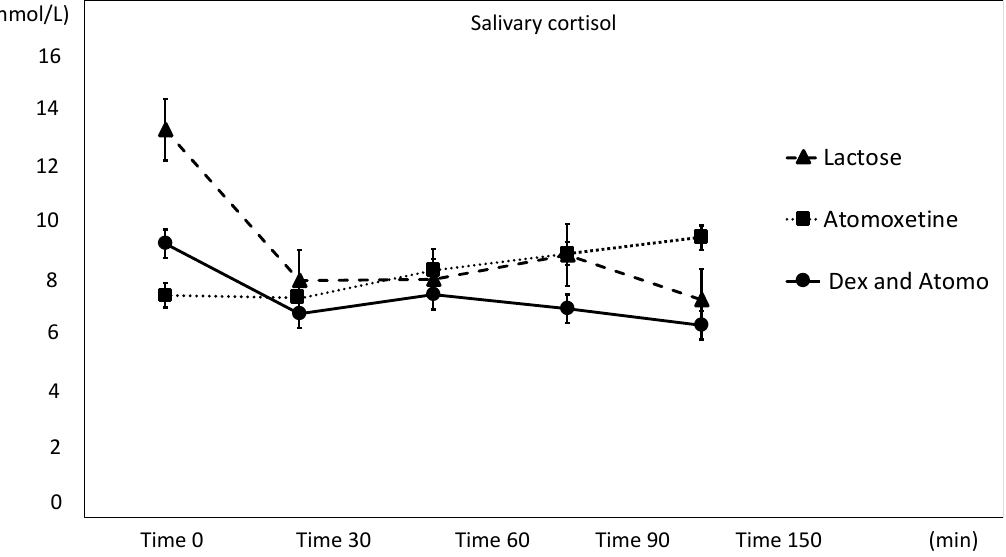
Figure 2. Salivary cortisol response to three treatments. Error bars reflect SEM.